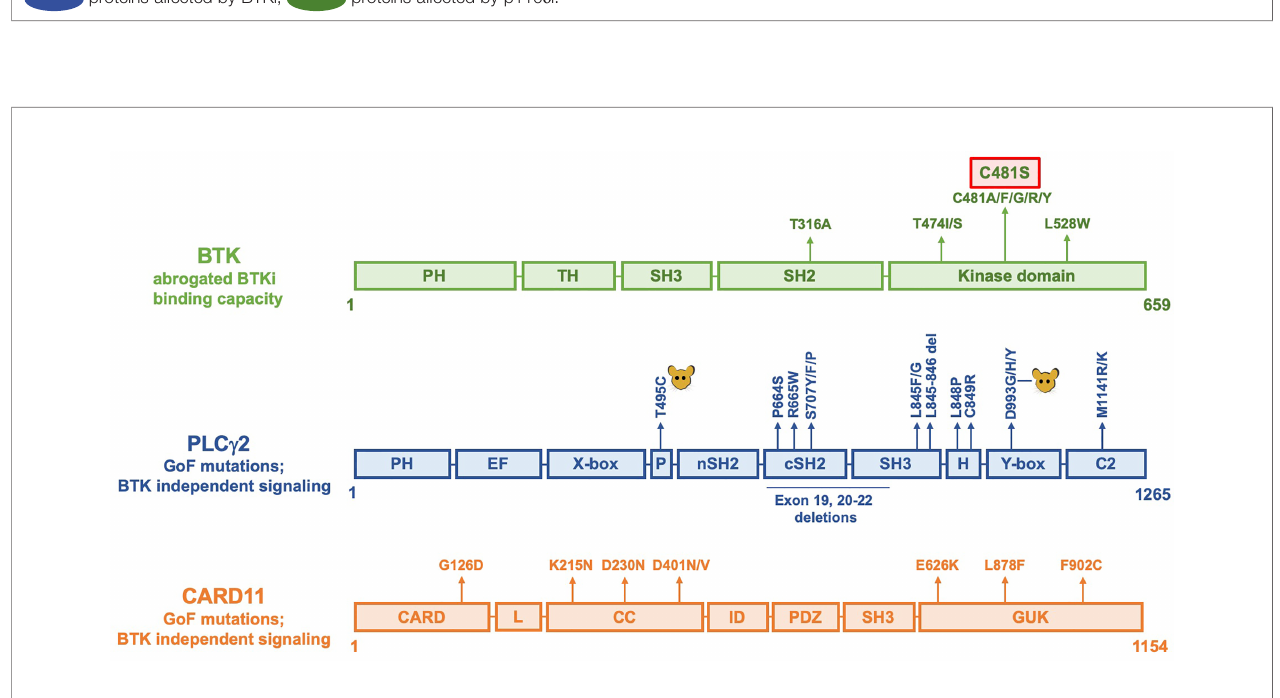
FIGURE 1 | The B cell receptor (BCR) signaling pathway and the effect of kinase inhibitors. The BCR pathway trifurcates into, from left, NF- k B, NFAT and AP-1 signaling. The AP-1 pathway is believed to be connected to the BCR through LYN, SYK and ZAP70 (not depicted). Filled protein symbols correspond to Gain-of- Function (GoF) drug resistance mutations. BTK inhibitors (BTKi) and p110 d inhibitors (p110 d i) are marked with yellow background. The MYD88 L265P GoF mutation found in 95% of WM patients, and also in ABC-type DLBCL, and in some CLL patients induces an activated endolysosome containing TLR9 and the BCR. proteins affected by BTKi, proteins affected by p110 d i.